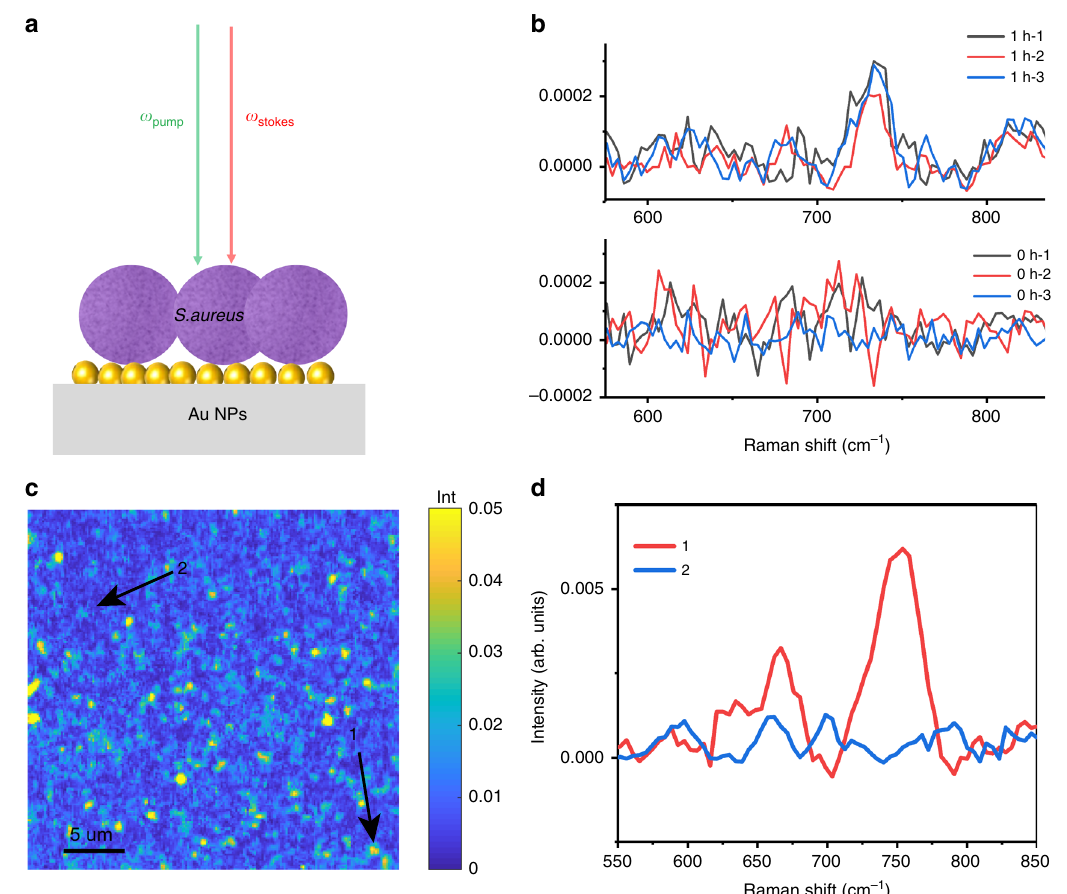
Fig. 5 PESRS mapping of adenine generated from stressed bacteria. a A schematic of PESRS mapping of adenine generated from stressed bacteria. b The PESRS spectra of S. aureus washed and kept in water for 1 h. The PESRS spectra of S. aureus obtained immediately (0h) after washing. Numbers 1, 2, 3 represent measurements at three locations on surface. No denoising applied. c Denoised PESRS image of starved S. aureus placed on the plasmonic substrate. The image area is 30 μ m × 30 μ m. d Single-pixel PESRS spectra of S. aureus on plasmonic substrate obtained from spot 1 and 2 indicated in panel c